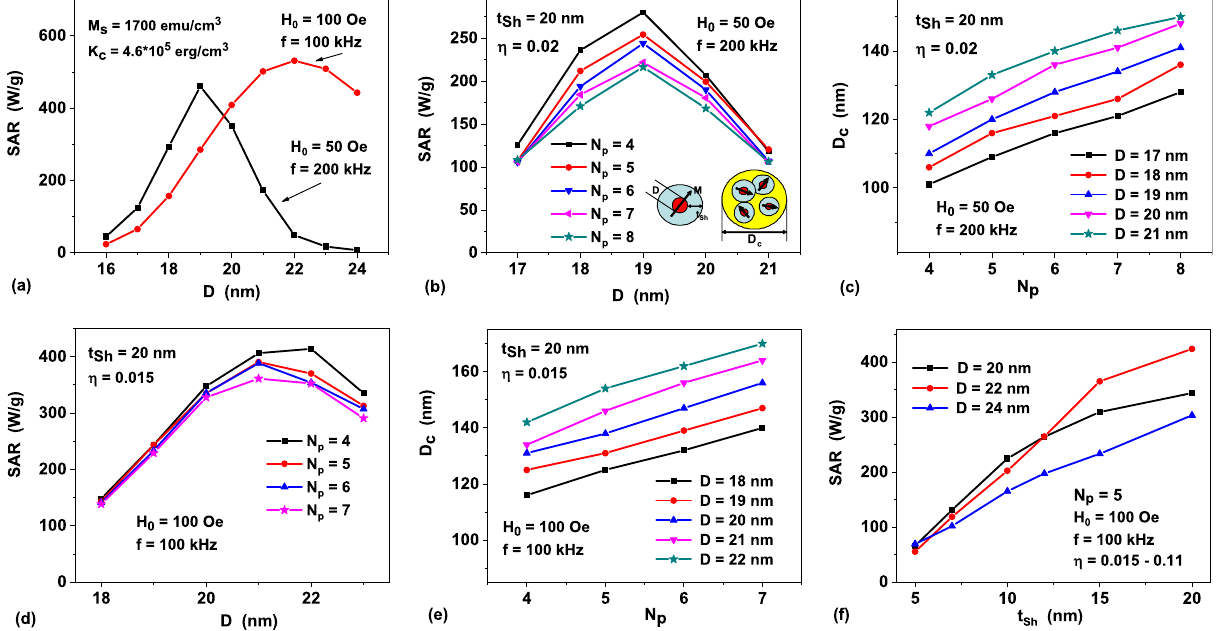
Figure 4. ( a ) SAR of an assembly of non interacting randomly oriented spherical iron nanoparticles as a function of particle diameter for various frequencies and ac magnetic field amplitudes; ( b ) SAR of a dilute assembly of magnetic capsules as a function of particle diameter for different number of nanoparticles within the capsule; ( c ) the size of the capsules D c as a function of particle number N p for different optimal particle diameters. For the panels ( b ) and ( c ) H 0 = 50 Oe, f = 200 kHz, η = 0.02. Inset in ( b ) shows the geometry and arrangement of nanoparticles into a capsule. ( d ), ( e ) the same as for the panels ( b ) and ( c ), but for the case H 0 = 100 Oe, f = 100 kHz, η = 0.015; ( f ) SAR of a dilute assembly of capsules as a function of non-magnetic shell thickness t Sh for various optimal particle